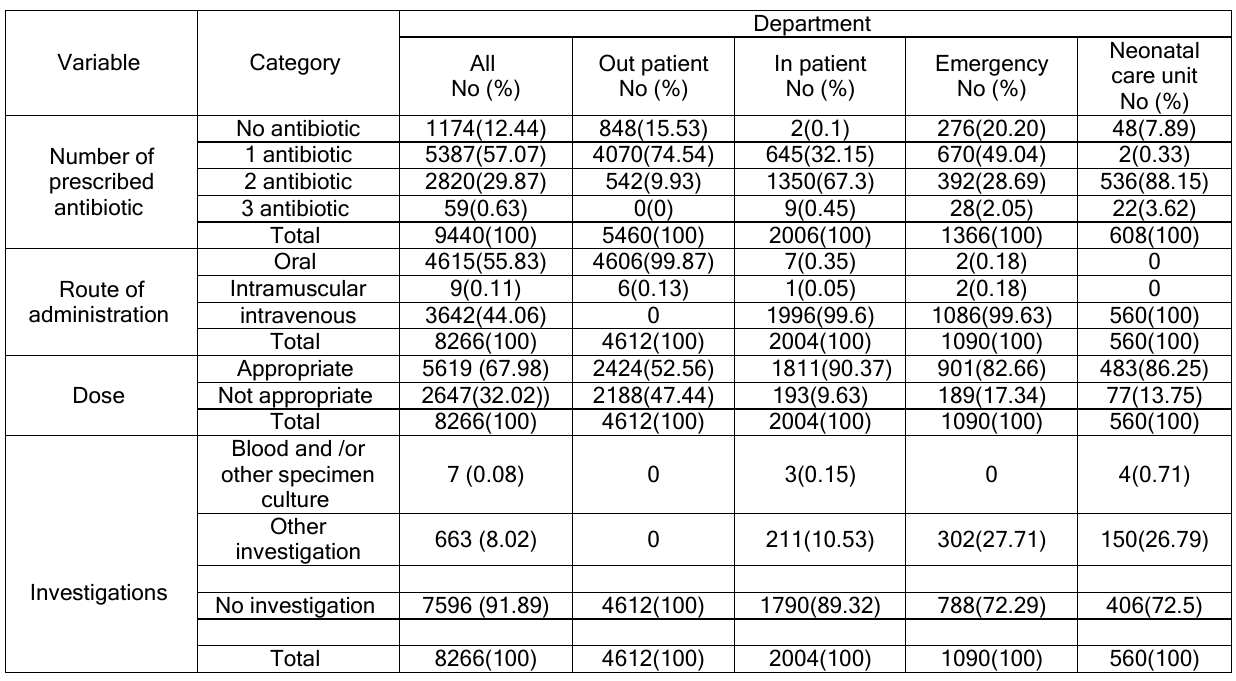
Table 3: Antibiotic prescription in all